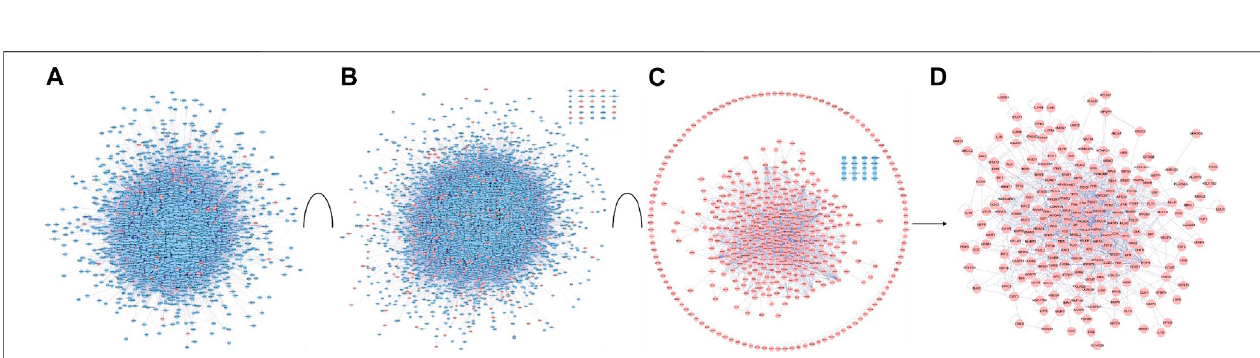
FIGURE 3 | PPI network construction and analysis for targets of G-Rh2 in lung cancer. (A) PPI network of G-Rh2 putative targets; (B) PPI network of lung cancer- related targets; (C) Interaction network of G-Rh2 targets and lung cancer-related targets; (D) Merged PPI network.